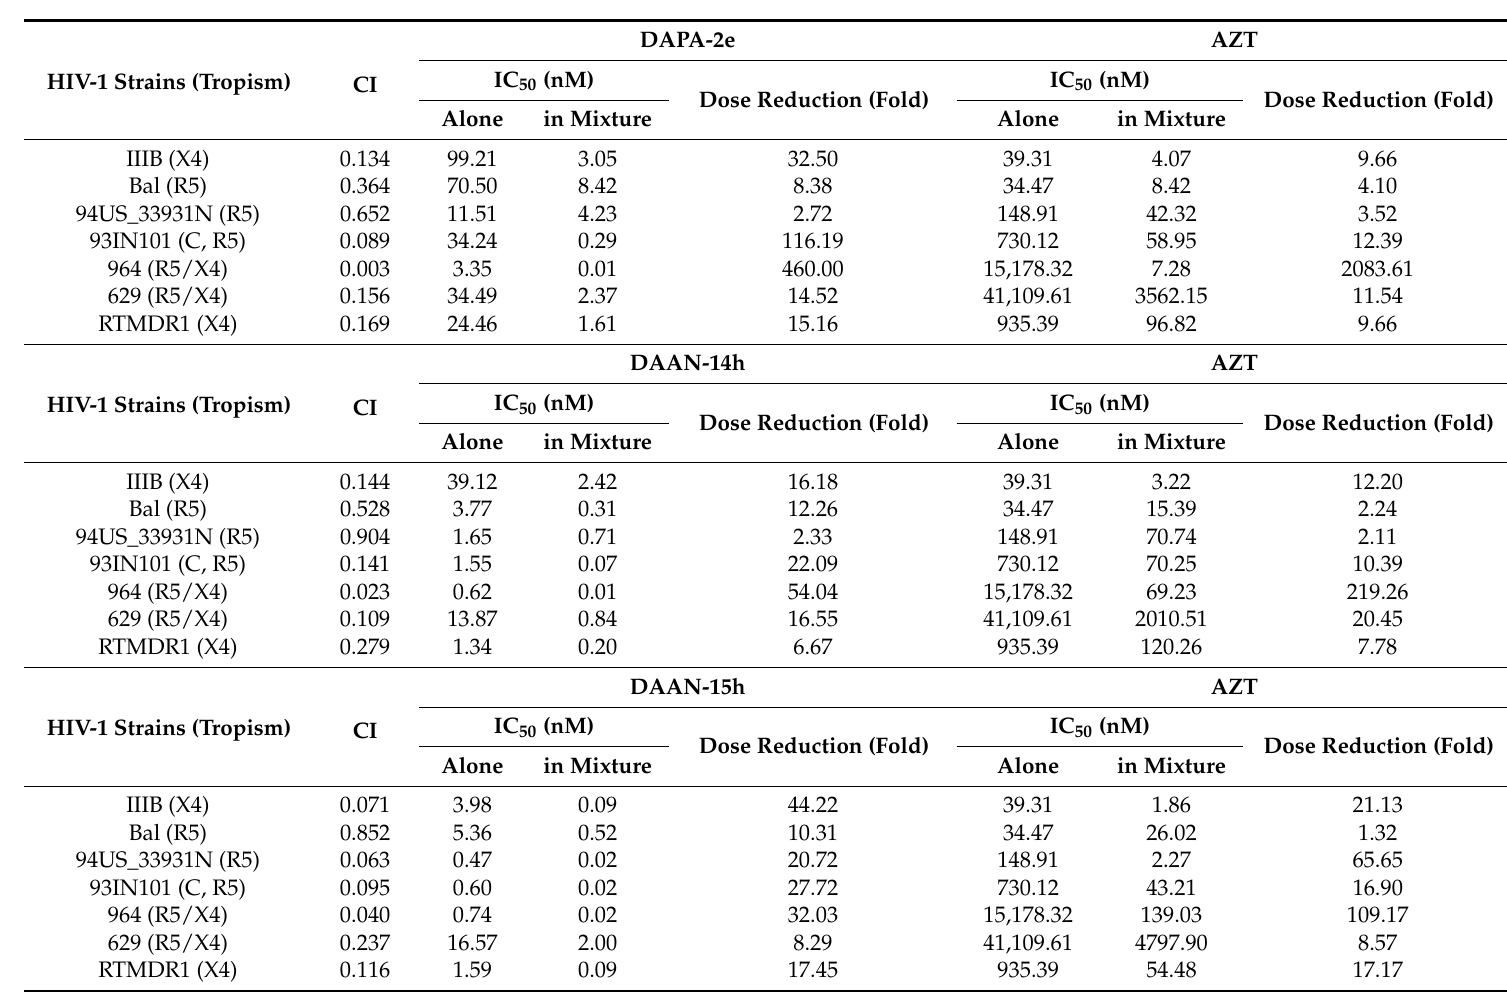
Table 1. Combination index (CI) and dose reduction in inhibition of infection by the HIV-1 strains by combining NNRTIs and AZT.